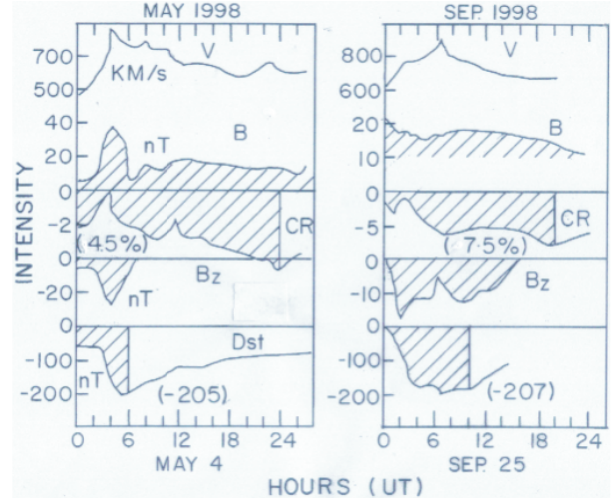
Fig. 1. Plots of hourly values of interplanetary V , B , B z , Cosmic ray intensity (CR) at Climax and geomagnetic disturbance index Dst, for the two events 4 May 1998 and 25 September 1998 (ND means no